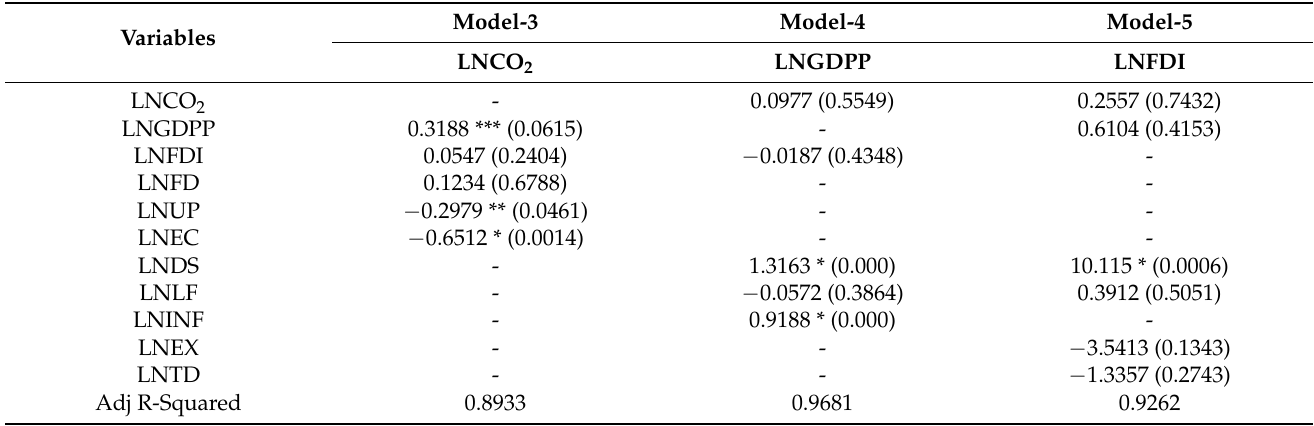
Table 4. Results for Panel of SAARC